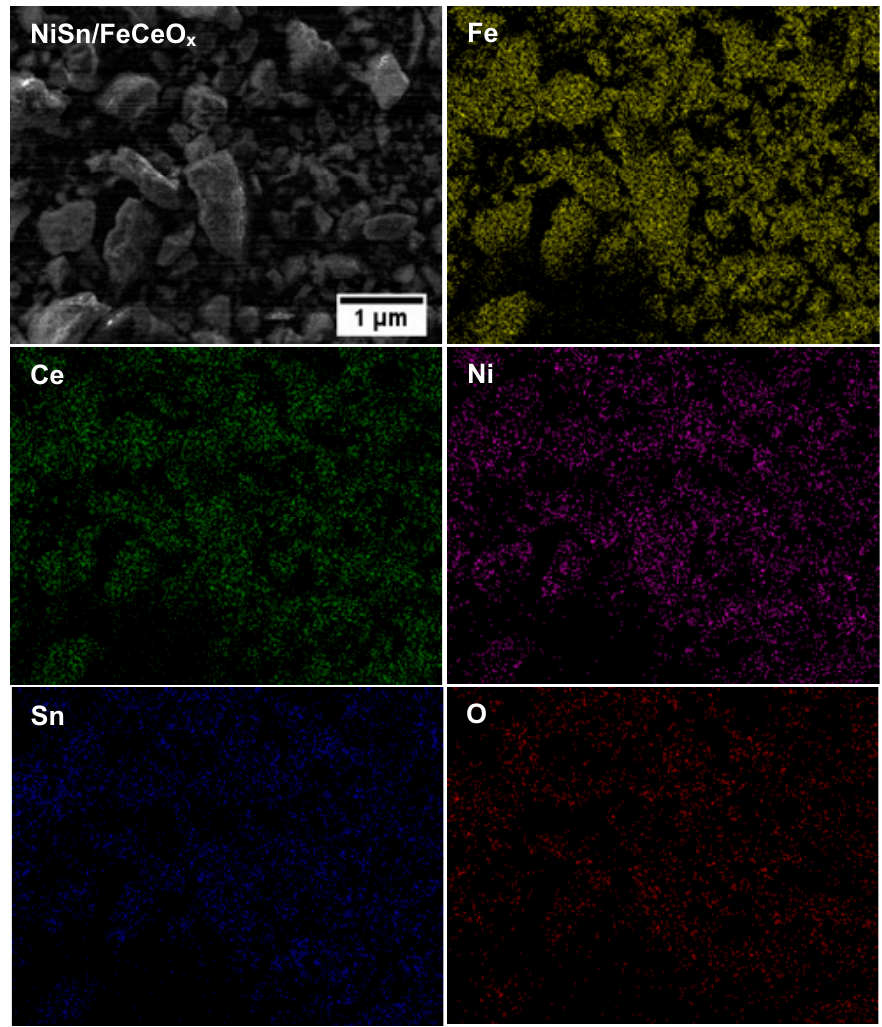
Figure 4. SEM image and elemental mapping of fresh NiSn/FeCeO x catalyst.